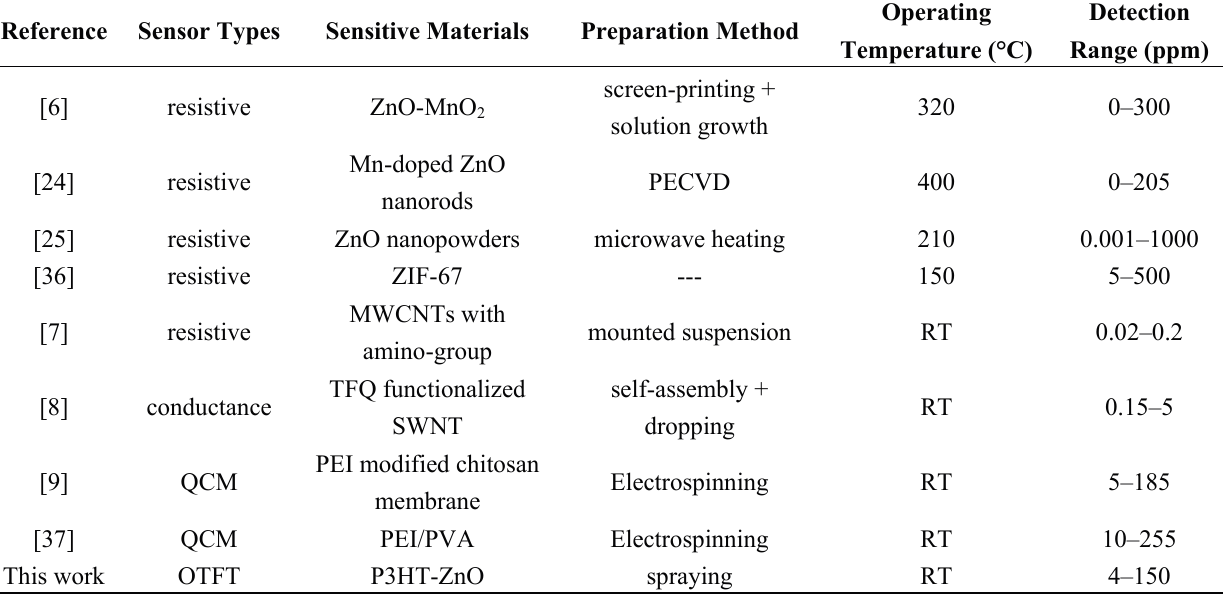
Table 1. Brief summary of results reported for various types of HCHO